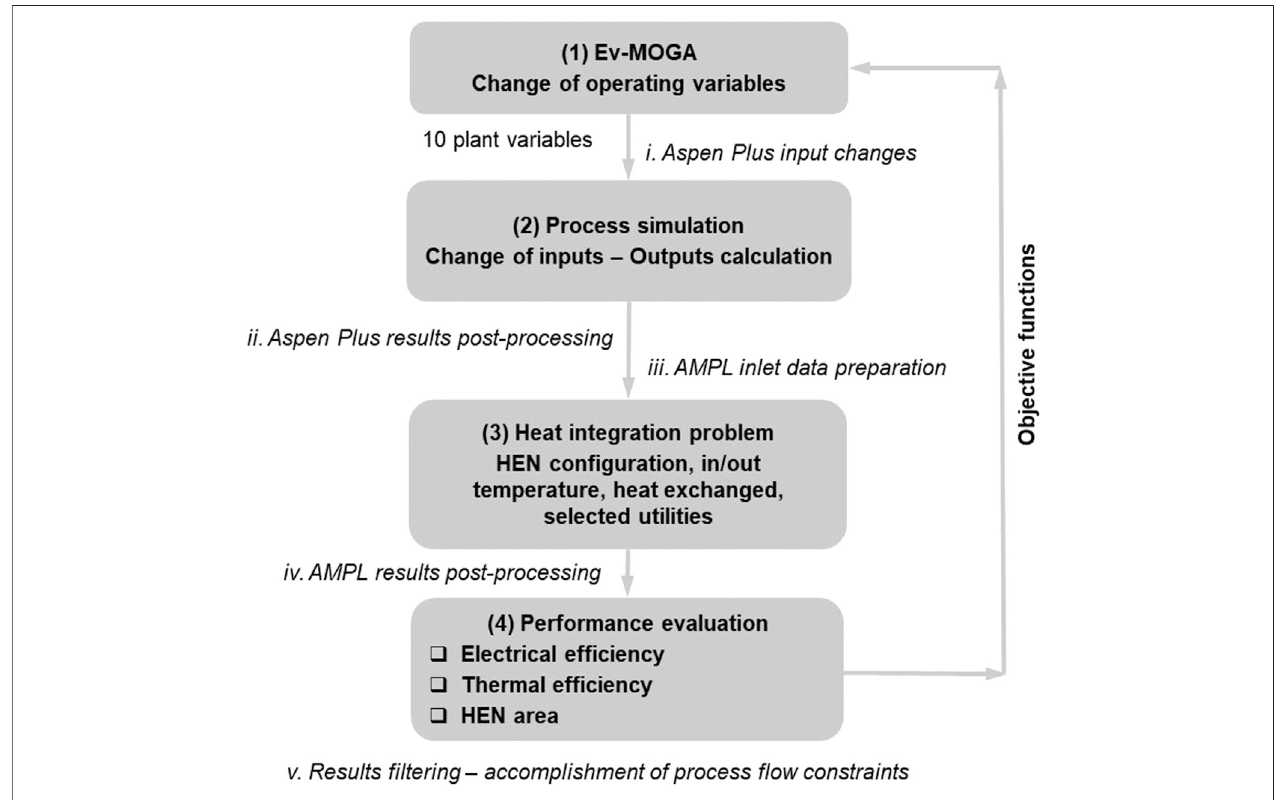
FIGURE 2 | Sequential multi-objective optimization approach for the Bio-SOFC process and HEN